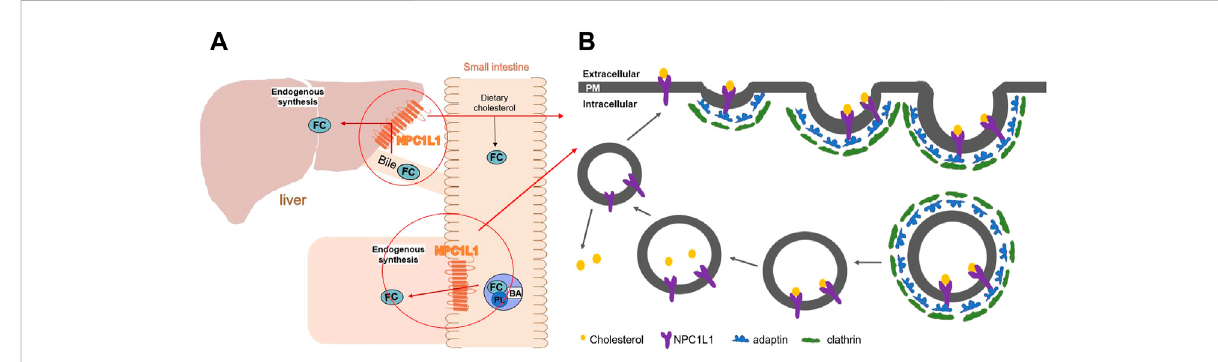
FIGURE 1 (A) Diagram of the mechanism of action of NPC1L1 in cholesterol transport in the small intestine and liver. (B) Working model for NPC1L1- mediated cholesterol uptake. (FC) Free cholesterol; (BA) bile acids; (PL) phospholipids; (PM) plasma